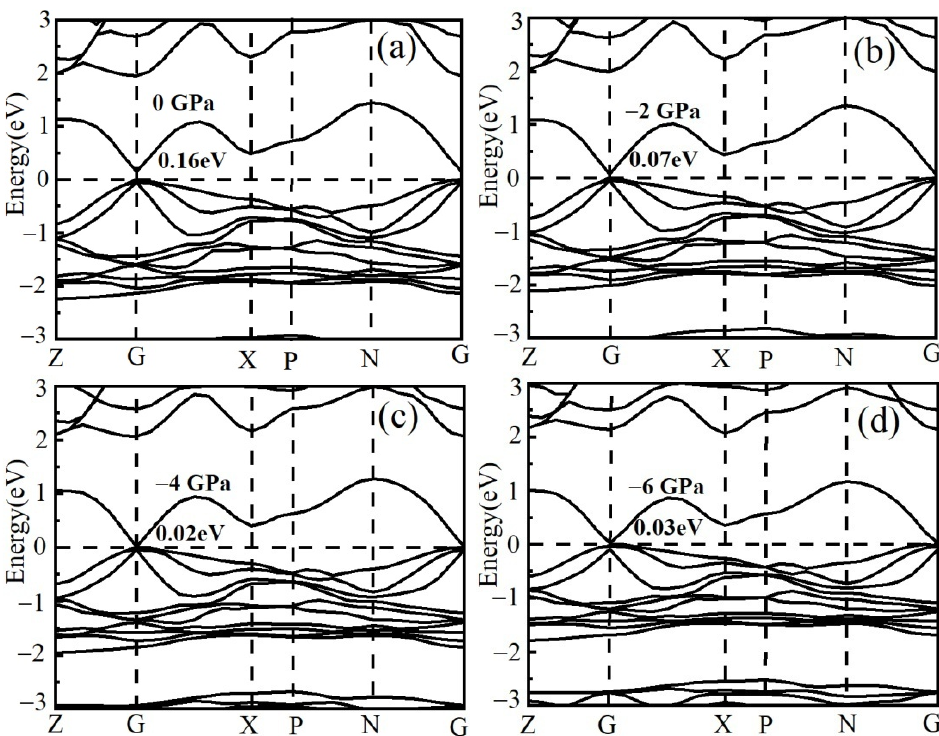
Figure 2. Band structure of Cu 2 ZnSnS 4 under tensile stress for ( a ) 0 GPa band structure; ( b ) − 2 GPa band structure; ( c ) − 4 GPa band structure; ( d ) − 6 GPa band structure. With the increase intensile stress, the bottom of the conduction band moves to the lower-energy direction, while the top of the valence band remains unchanged; the band gap decreases with the increase intensile stress, and the band gap reaches a minimum value of 0.02 eV when the tensile stress is − 4 GPa. After this, the band gap widens with the increase intensile stress. This is because the bottom of the conduction band of CZTS moves toward the high-energy direction after the tensile stress continues to increase, valence band moves down toward the low-energy direction, and the band gap